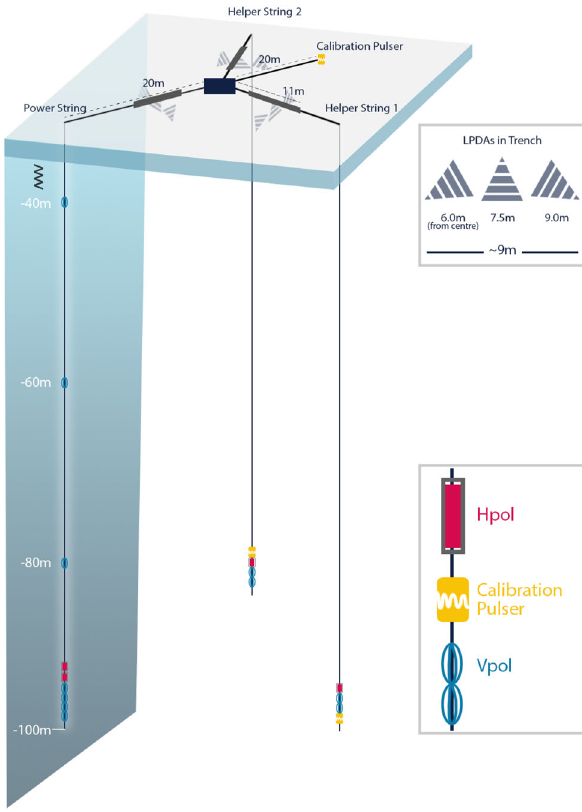
Fig. 1 Layout of one of the 35 detector stations that will make up the Radio Neutrino Observatory Greenland (RNO-G). From